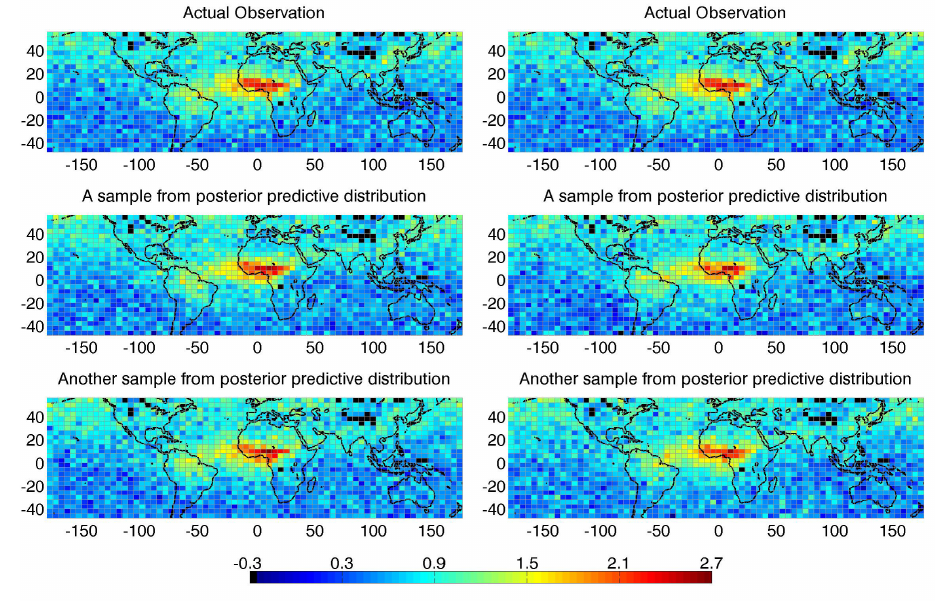
Fig. 10. Two samples of column CO fields (in units of 10 18 moleculesCOcm − 2 ) from the posterior predictive distributions of NS (lower 2 left panels) and CAR (lower 2 right panels) models for December 2000 for L = 100km; top panels show the corresponding synthetic data.